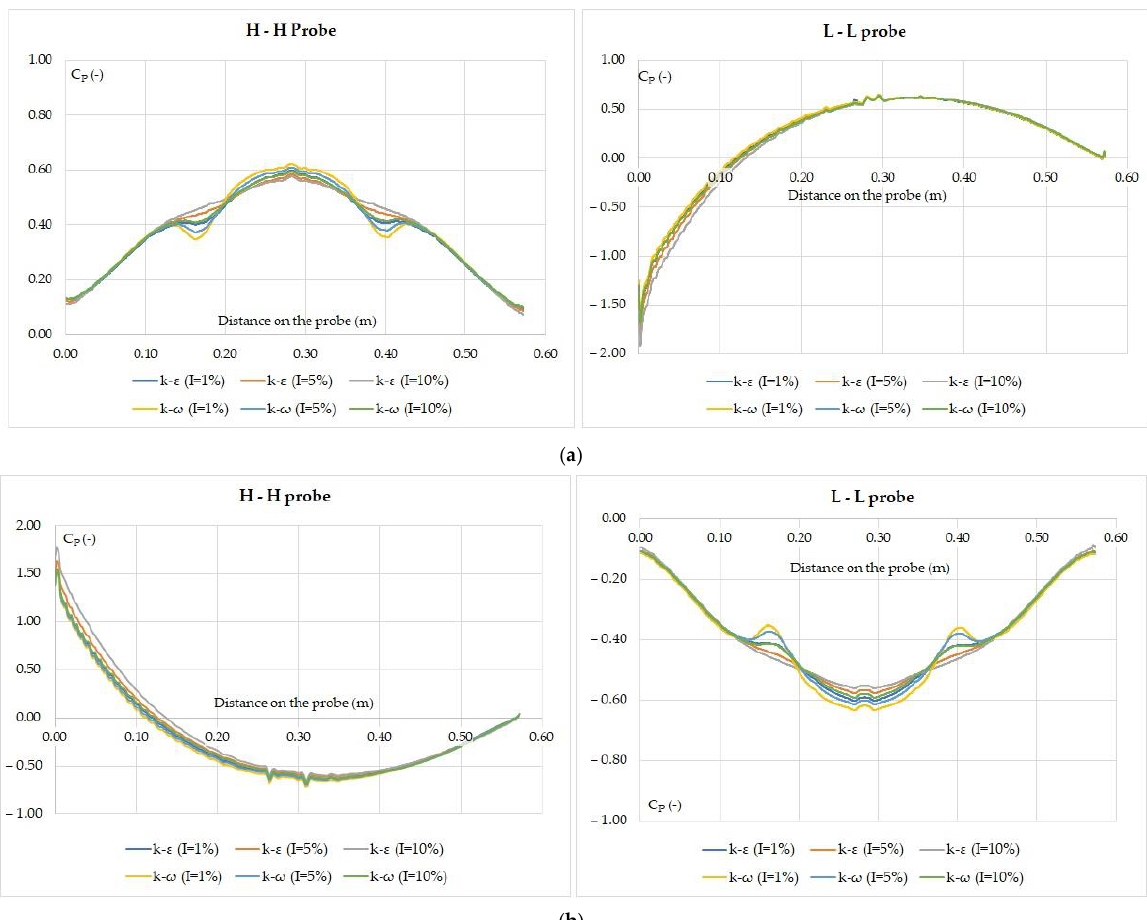
Figure 6. Mean C p distribution for the hypar roof using different turbulence models. ( a ) Mean C p distribution for the direction of the wind parallel to the LL plane. ( b ) Mean C p distribution for the direction of the wind parallel to the HH plane.